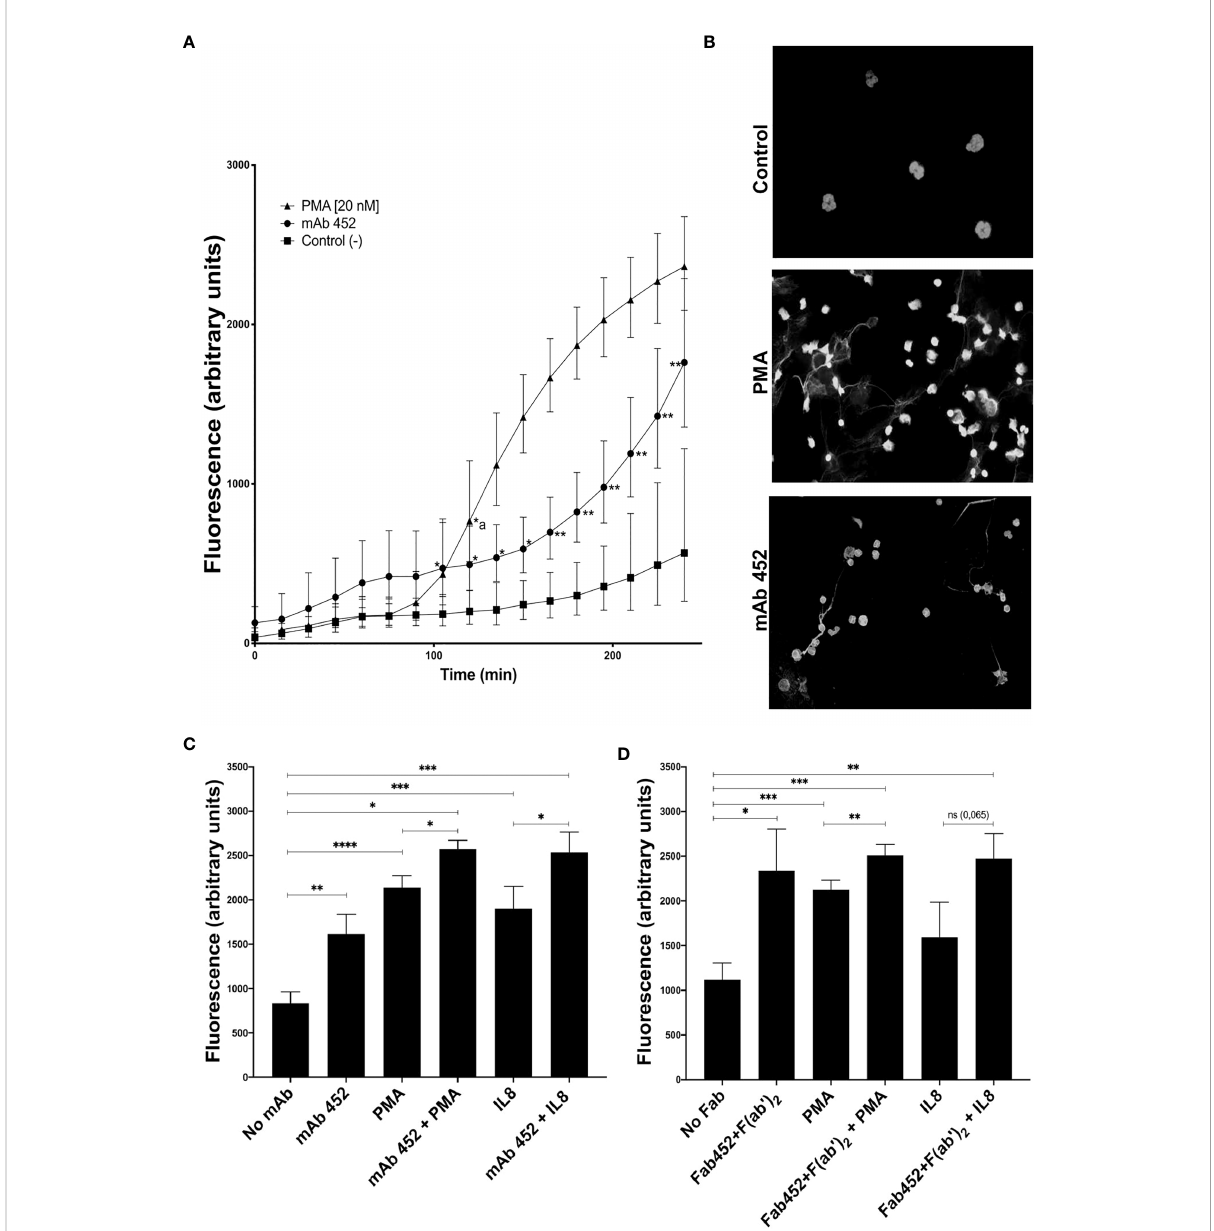
FIGURE 5 CD13 crosslinking induces neutrophil extracellular traps (NETs). Neutrophils were left untreated (control) or were incubated with mAb 452 or its Fab fragments for 30 minutes, washed, and stimulated with PMA (20 nM) or IL-8 (10 ng/ml) for 240 minutes, and fl uorescence of extracellular DNA was evaluated with SYTOX-Green. (A) Time-course of SYTOX-Green fl uorescence in cells stimulated with PMA, mAb 452 (anti-CD13) or non-stimulated. Fluorescence values are the mean ± SEM of 6 independent experiments. Statistical signi fi cance was calculated using one-way ANOVA with Tukey ’ s post hoc test (* p< 0.05, **p< 0.01) (*a: in the PMA curve, values are signi fi cantly different from control from 120 minutes onwards). (B) Immuno fl uorescence images of neutrophils stimulated with PMA, mAb 452 or non-stimulated for 240 min, fi xed and incubated with Hoechst 33342 ® to visualize extracellular DNA. (C, D) NETs release from human neutrophils stimulated for 240 min with mAb 452 (C) , or Fab 452 plus F(ab ’ )2 fragments of anti-mouse Ig (D) , PMA, or IL-8, or the combinations shown. Statistical signi fi cance was computed through a one-way ANOVA with a Tukey post hoc test. *p<0.05, **p<0.01, ***p<0.001,